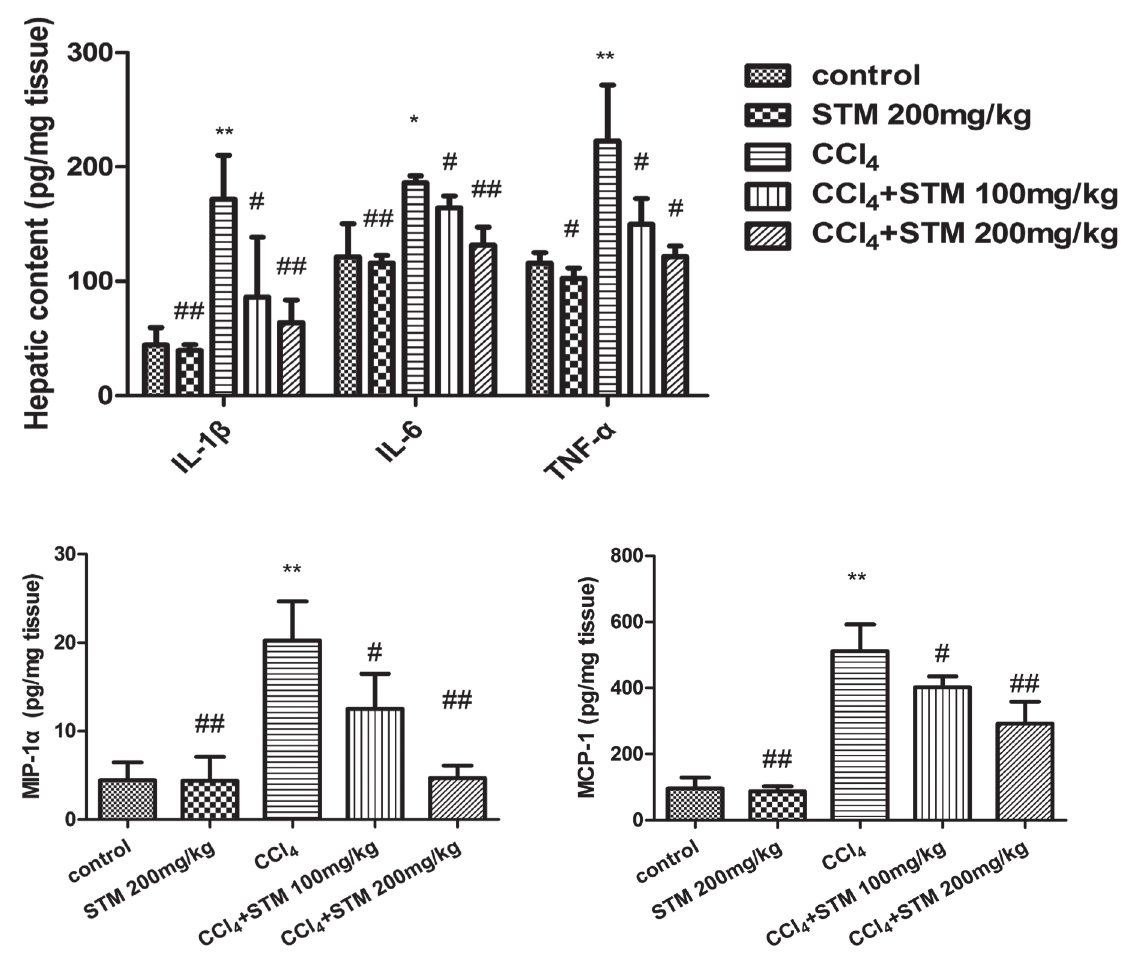
FIGURE 3 - STM inhibited the hepatic production of IL-1β, IL-6, TNF-α, MIP-1α, and MCP-1. The contents of IL-1β, IL-6, TNF-α, MIP-1α, and MCP-1 in liver were significantly increased following 8 weeks of chronic CCl exposure compared with the controls. 4 STM (100 and 200 mg/kg) treatment reduced the production of IL-1β, IL-6, TNF-α, MIP-1α, and MCP-1 notably compared with the CCl group. Data are represented as means ± S.D. for 7-12 animals per group. * p < 0.05 versus control, ** p < 0.01 versus control; 4 # p < 0.05 versus CCl , ## p < 0.01 versus CCl by one-way ANOVA and LSD post hoc 4 4